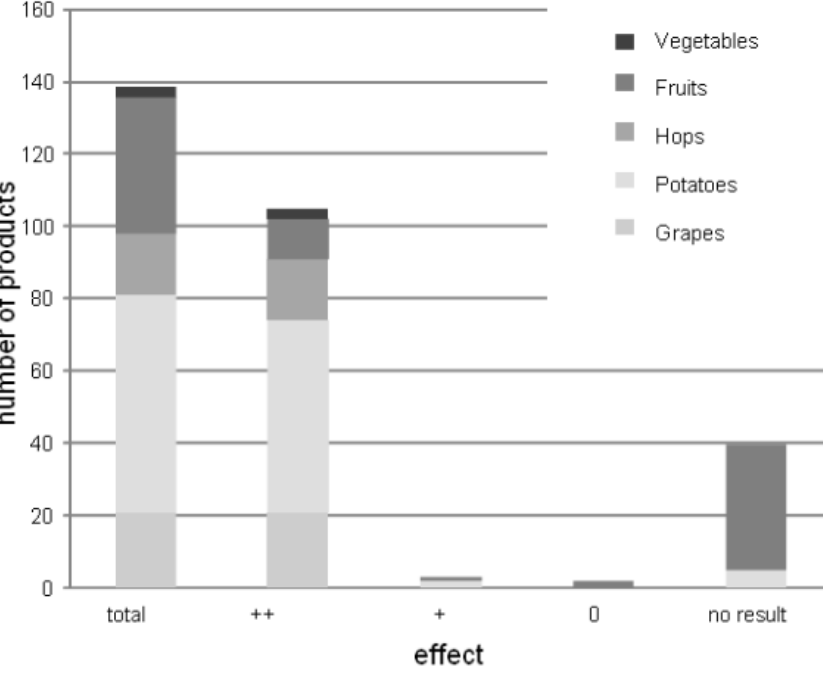
Figure 3. Number of copper products field-tested under the B ¨OLN program and their effects in different crops. Symbols: ++ (significant effect), + (effective in the laboratory/greenhouse but not in the field), 0 (no